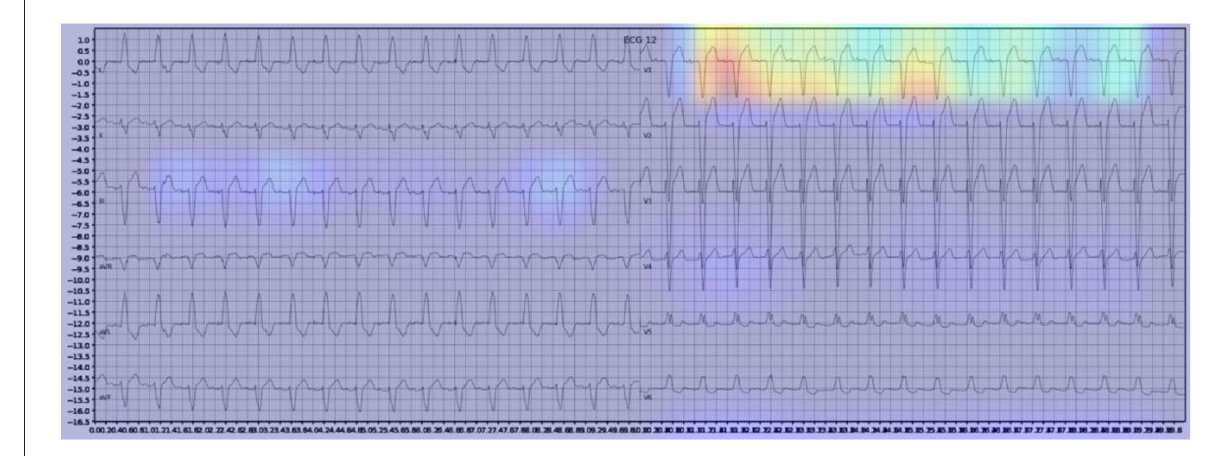
FIGURE5 Example of an activation heatmap for an ECG showing LBBB.